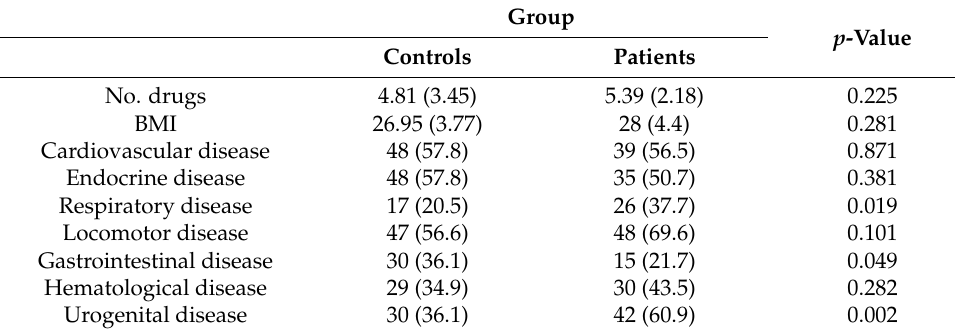
Table 2. Description and comparison of clinical variables of the two study groups.